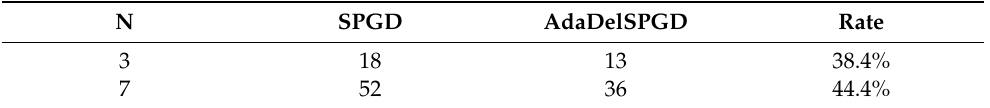
Table 1. The numerical results of the convergence speed.